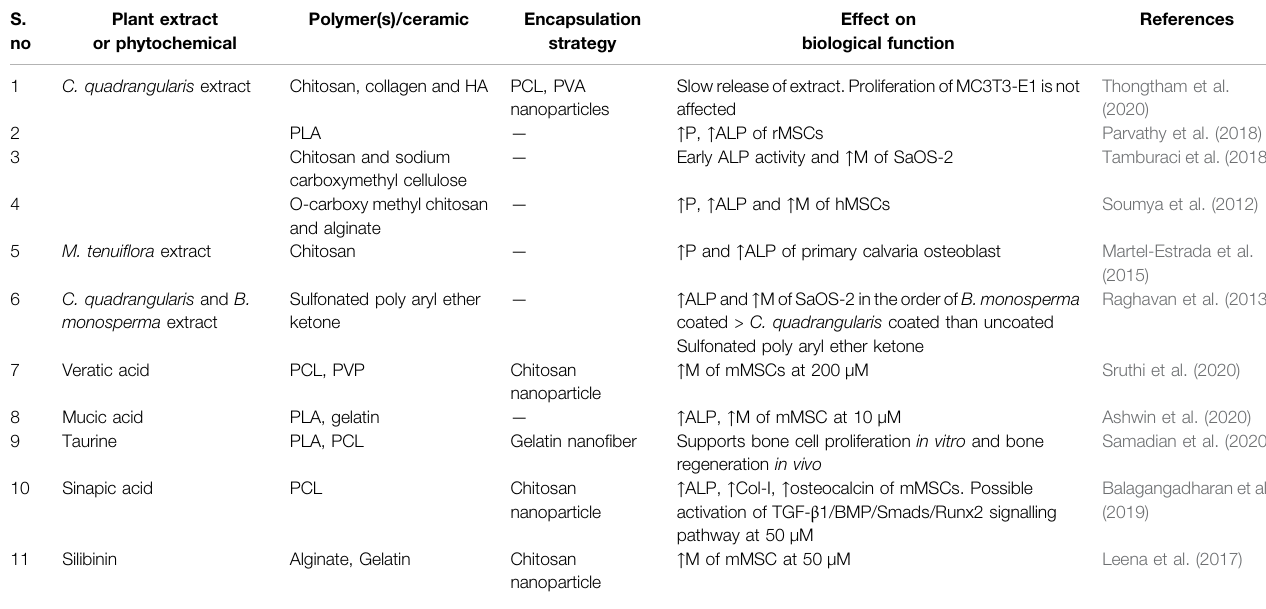
TABLE 3 | Effect of phytochemicals on scaffold towards osteoblasts and microbes. S.